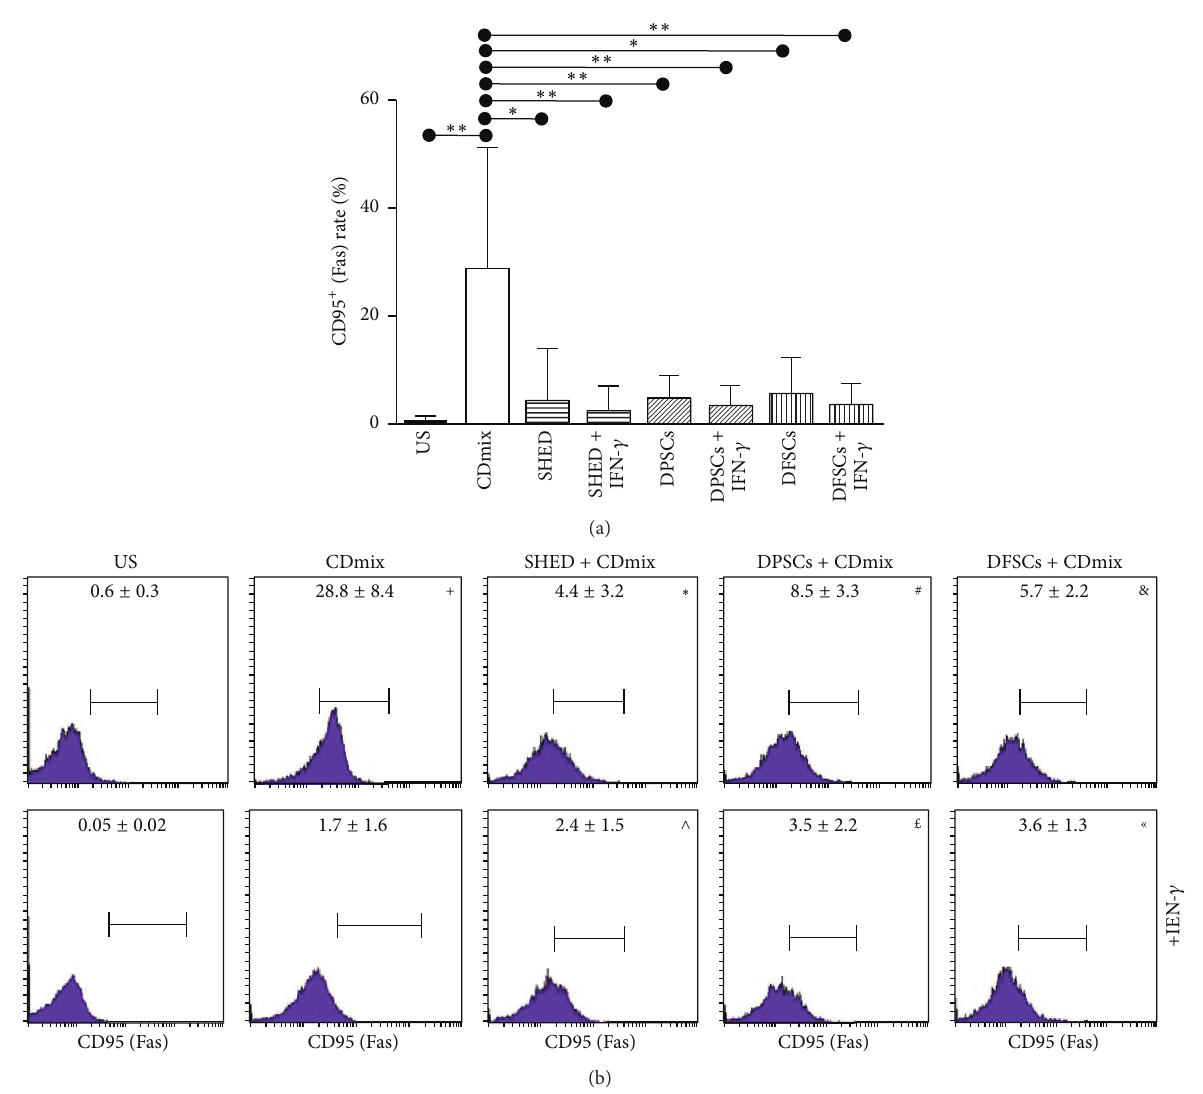
Figure 6: Inhibitory effect of SHED, DPSCs, and DFSCs on the apoptosis of lymphocytes as detected by Fas/FasLigand kit. (a) Inhibitory effect of SHED, DPSCs, and DFSCs on Fas (CD95) rate of lymphocytes displayed statistically. (b) Inhibitory effect of SHED, DPSCs, and DFSCs on Fas (CD95) rate of lymphocytes displayed by flow cytometry. + 𝑃 < 0.01 , compared with US group. ∗ 𝑃 < 0.05 , compared with CDmix group. # 𝑃 < 0.01 , compared with CDmix group. & 𝑃 < 0.05 , compared with CDmix group. ∧ 𝑃 < 0.01 , compared with CDmix group. m 𝑃 < 0.01 , compared with CDmix group. « 𝑃 < 0.01 , compared with CDmix